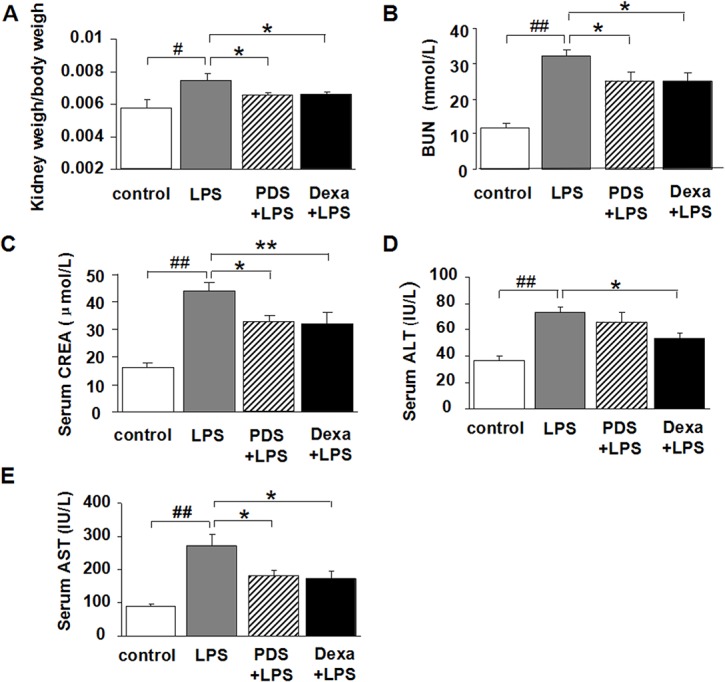
Effects of PDS on kidney, hepatic and cardiac markers in mice.A: Kidney index = kidney weight/body weight; B:Serum Blood Urea Nitrogen (BUN); C: Serum creatinine (CREA); D: Serum alanine transaminase (ALT); E: Serum aspartate aminotransferase (AST). LPS: lipopolysaccharide; PDS: Panaxadiol saponins; Dexa: dexamethasone. Data represent mean ± SEM. #P<0.05 and ##P<0.01 vs. control group; *P<0.05 and **P<0.01 vs. LPS group (n = 8 per group).